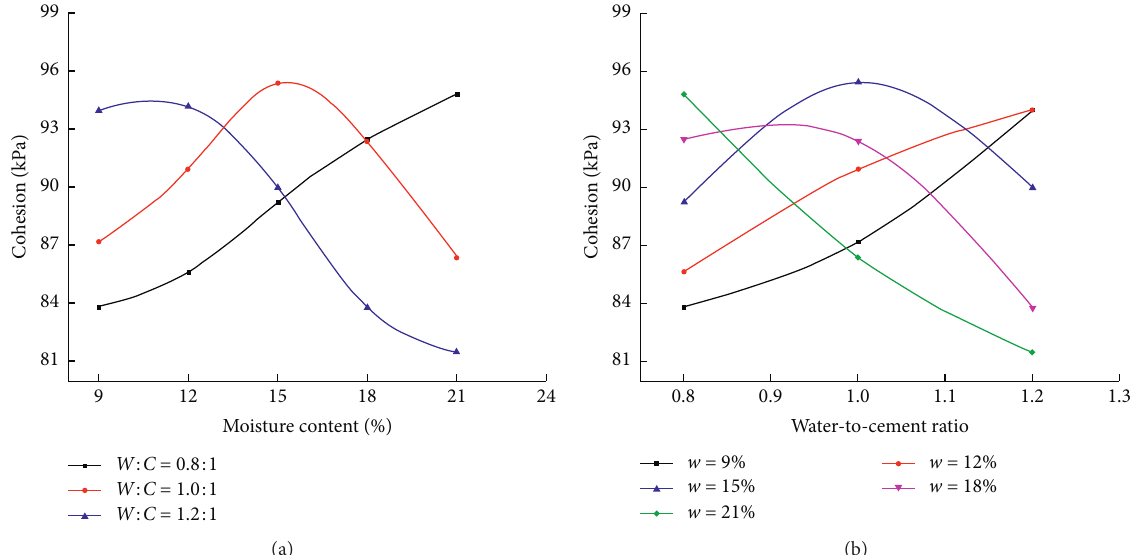
Figure 7: Reinforced loess cohesion vs. moisture content and water-to-cement ratio. (a) c − w curve. (b) c − W : C curve.